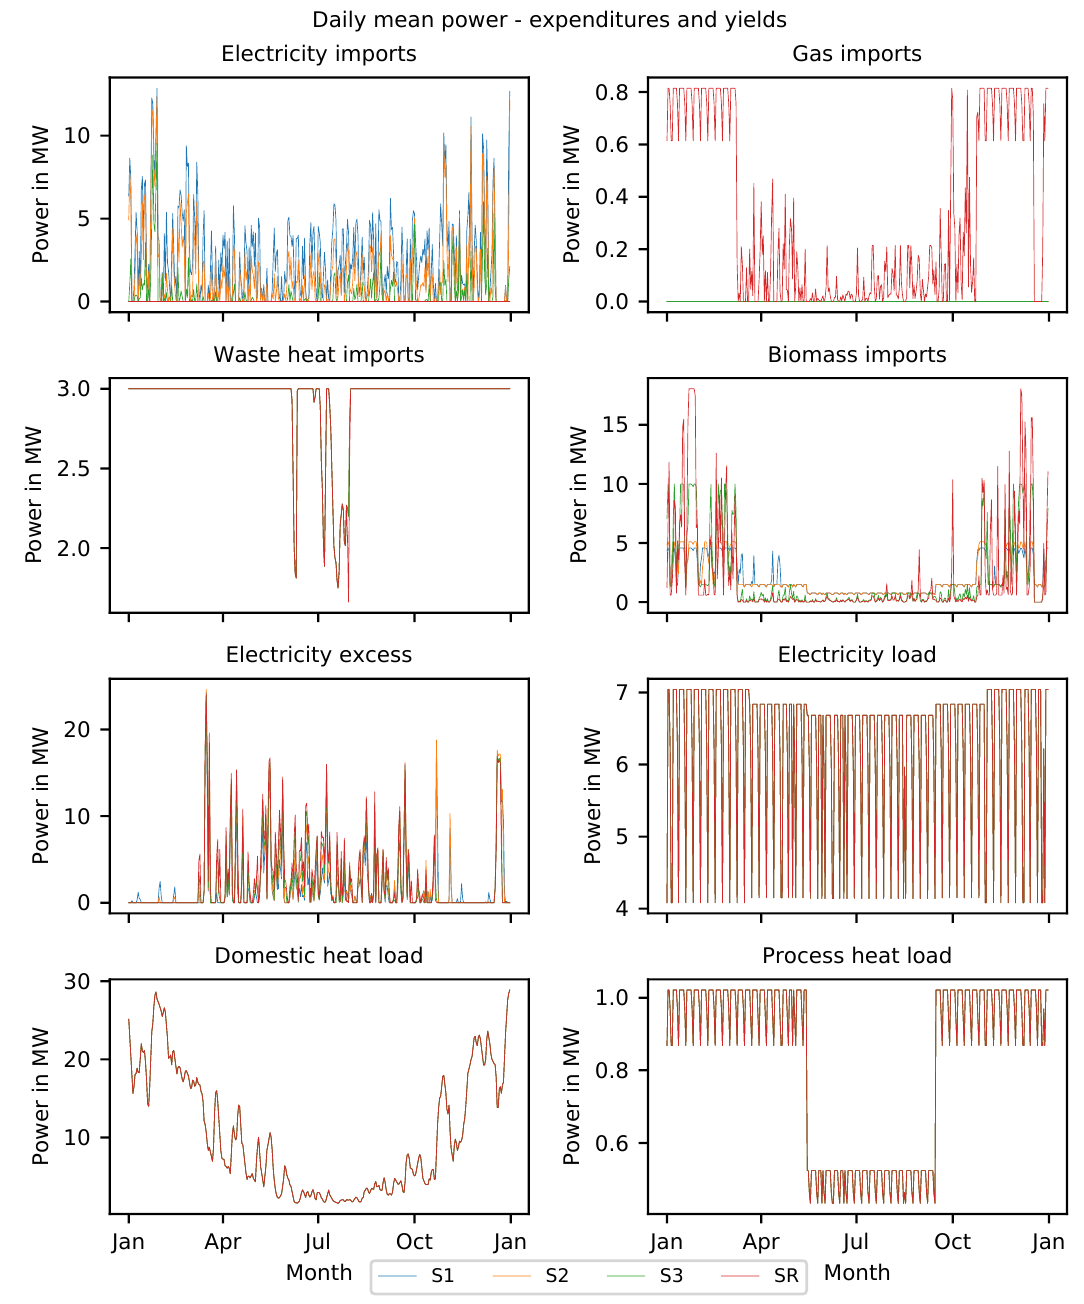
Figure 12. Daily mean power of the operational expenditures and yields. (Source: own representation). For domestic heat, the situation is different. The maximum waste heat import power of 3 MW covers only 8% of the maximum domestic heat load. The remaining heat will be provided by the plants with the lowest total unit expenditures, under the consideration that the local biomass has to be used. The biomass is used in a biomass CHP which is mainly operated in times where the heat demand is high and PV yields are low. Heat pumps together with thermal energy storage cover the rest. From S2 to S3 the CExC-factor and therefore the unit expenditures for electricity imports rises from 1.5 MW to 2 MW . This results in an increase of the battery storage capacity from 2 MW h to 39.5 MW h MW MW and of the thermal energy storage from 895 MW h to 2193 MW h. Apart from the two scenarios, there are no others where the increase in storage capacity is so large. As already discussed